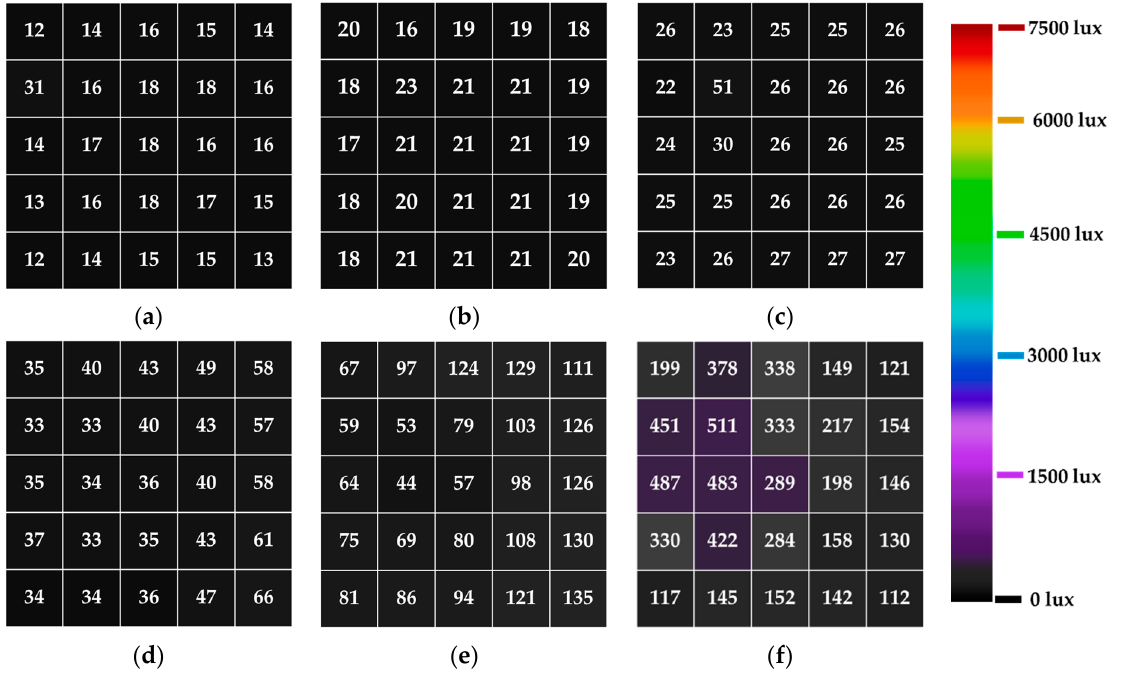
Figure 11. Light transmission performance of light tubes with different materials with diameters of ( a ) 0.20 m, ( b ) 0.25 m, and ( c ) 0.30 m.